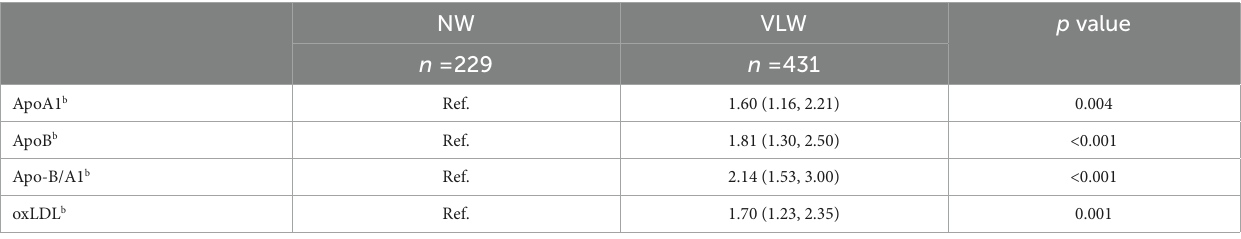
TABLE 2 Associations between low-mineral DDW exposure and serum biomarkers of cardiovascular system. a